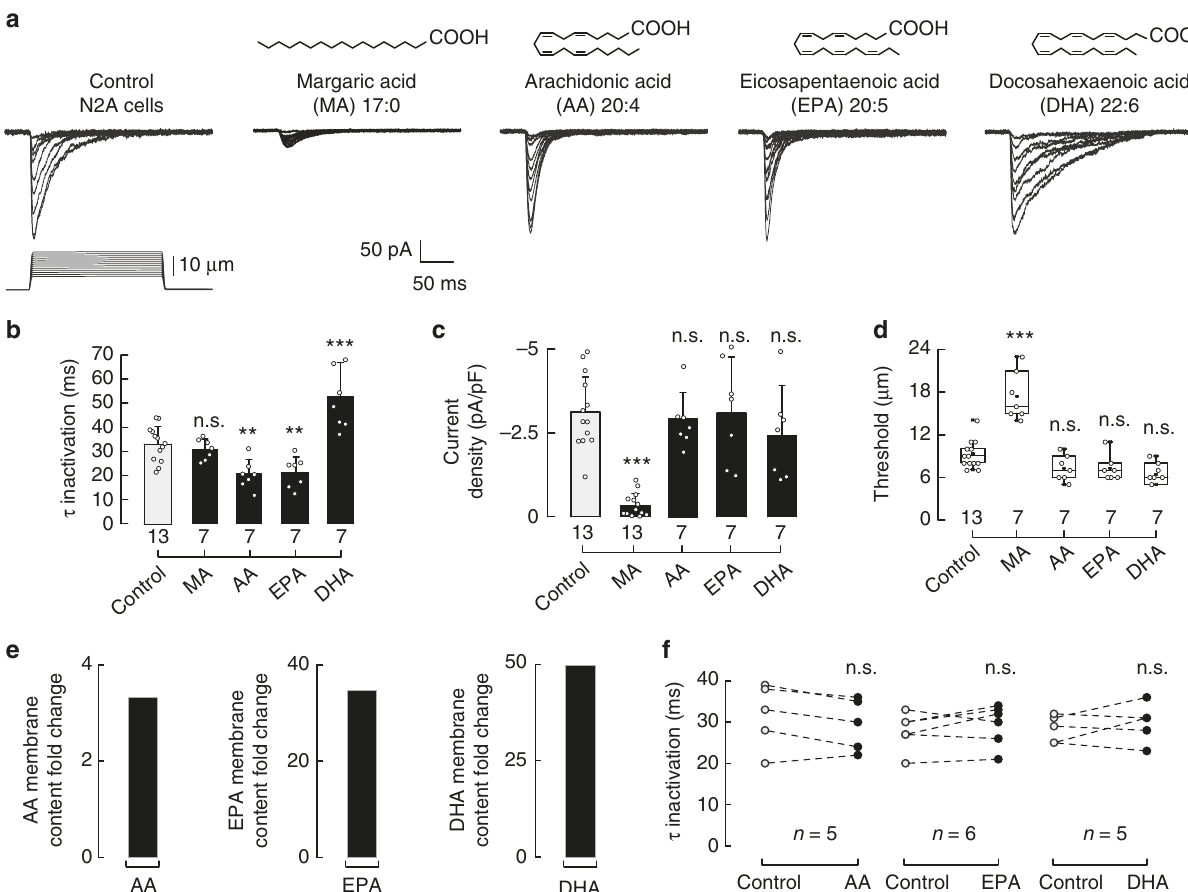
Fig. 2 Dietary fatty acids alter Piezo1 channel gating. a Representative whole-cell patch-clamp recordings (at − 60 mV) of control, MA, AA, EPA, and DHA (100 µ M)-treated N2A cells elicited by mechanical stimulation. The structures of MA, AA, EPA, and DHA are displayed above. b Piezo1 time constants of inactivation elicited by maximum displacement of control, MA, AA, EPA, and DHA (100 µ M)-treated N2A cells. Bars are mean ± SD. One-way ANOVA and Bonferroni test. c Current densities elicited by maximum displacement of control, MA, AA, EPA, and DHA (100 µ M)-treated N2A cells. Bars are mean ± SD. Kruskal – Wallis and Dunn ’ s multiple comparisons test. d Boxplots show the mean, median, and the 75th to 25th percentiles of the displacement threshold required to elicit Piezo1 currents of control, MA, AA, EPA, and DHA (100 µ M)-treated N2A cells. One-way ANOVA and Bonferroni test. e AA, EPA, and DHA membrane content fold change in N2A cells treated with AA, EPA, and DHA 100 µ M for 18 h, as determined by liquid chromatography-mass spectrometry (LC-MS). f Piezo1 time constants of inactivation elicited by maximum displacement of N2A cells perfused for 120 s with bath solution (control) and a PUFA (AA, EPA, and DHA; 100 μ M). Data samples are paired. Paired t -test. Asterisks indicate values signi fi cantly different from control ( ∗∗∗ p < 0.001 and ∗∗ p < 0.01) and n.s. indicates not signi fi cantly different from the control. n is denoted above the x -axes